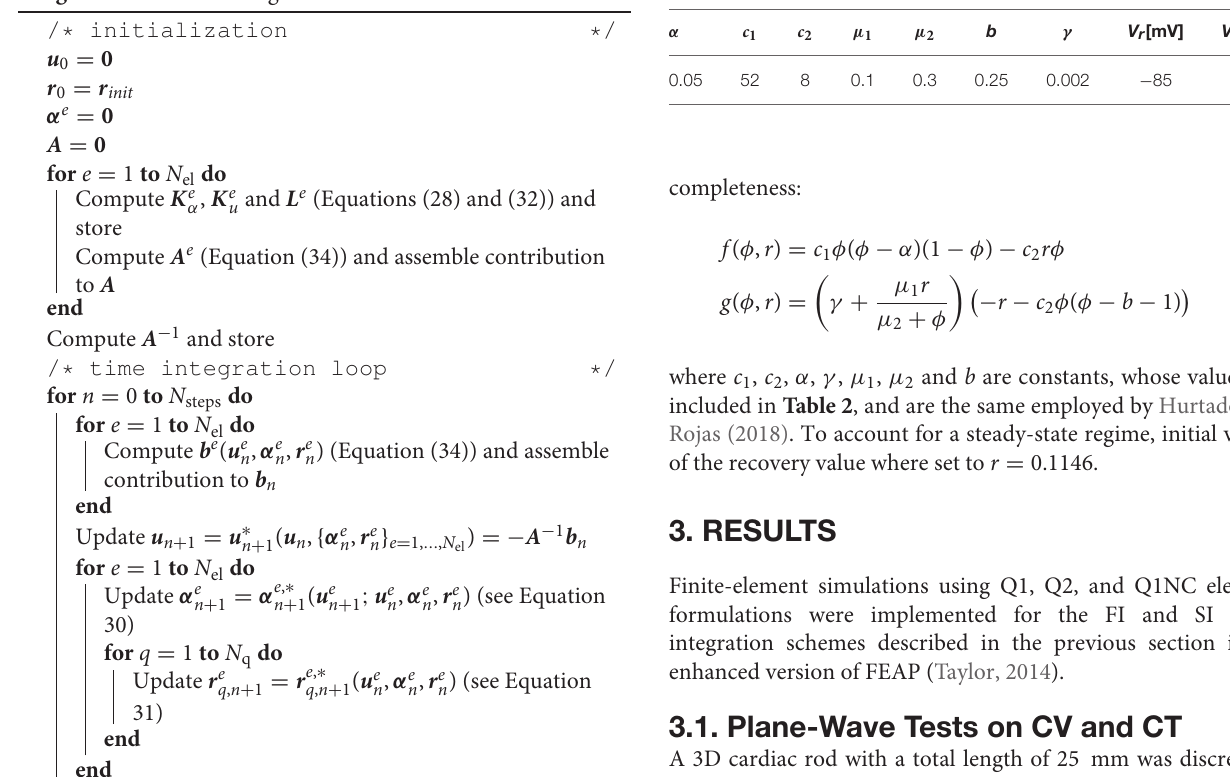
TABLE 2 | Parameter values for the modified Aliev-Panfilov